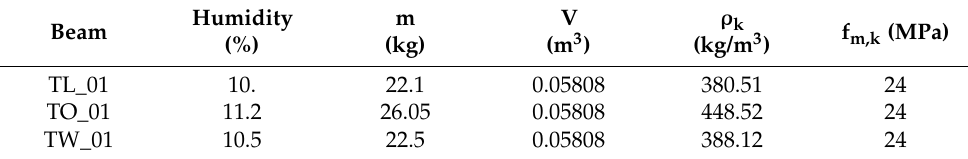
Table 1. Physical and material properties of timber